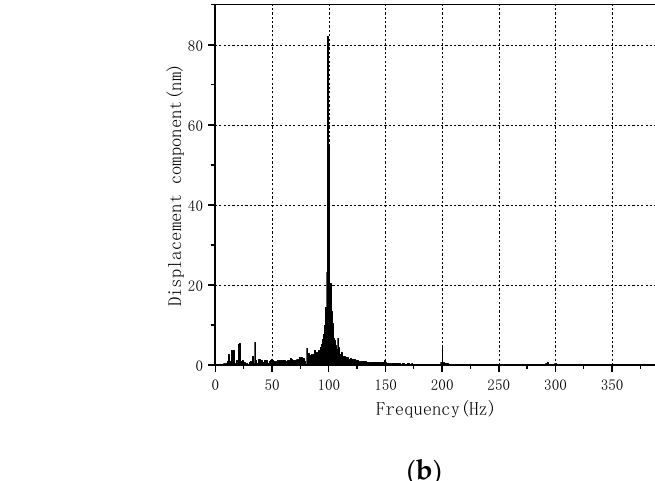
Figure 7. Vibration displacement of iron core without inter-harmonics; ( a ) time-domain waveform; ( b ) spectrum analysis.